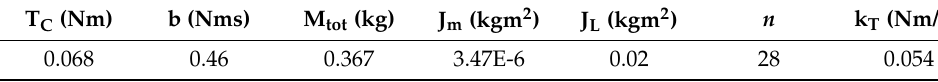
Table A1. Parameters of the impactor mechanism.